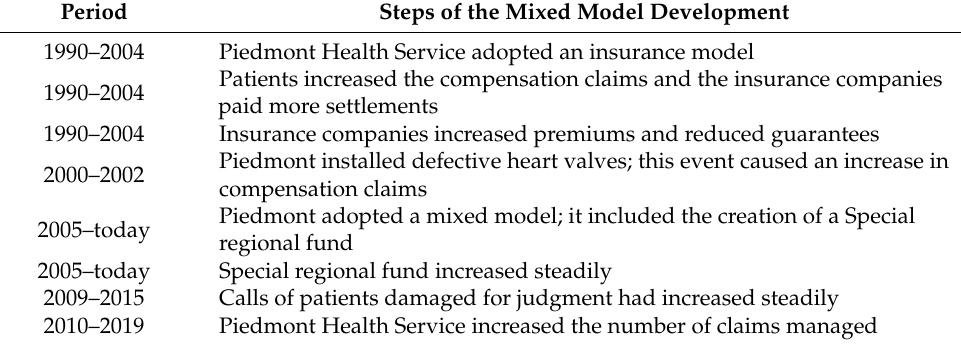
Table 4. The main steps of the mixed model